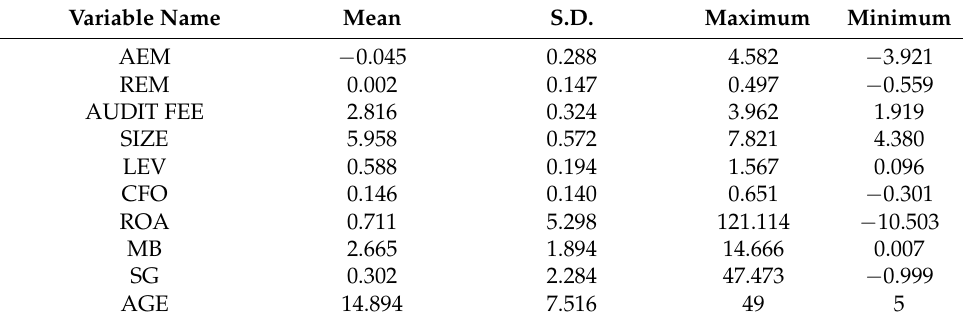
Table 1. Descriptive statistics of quantitative